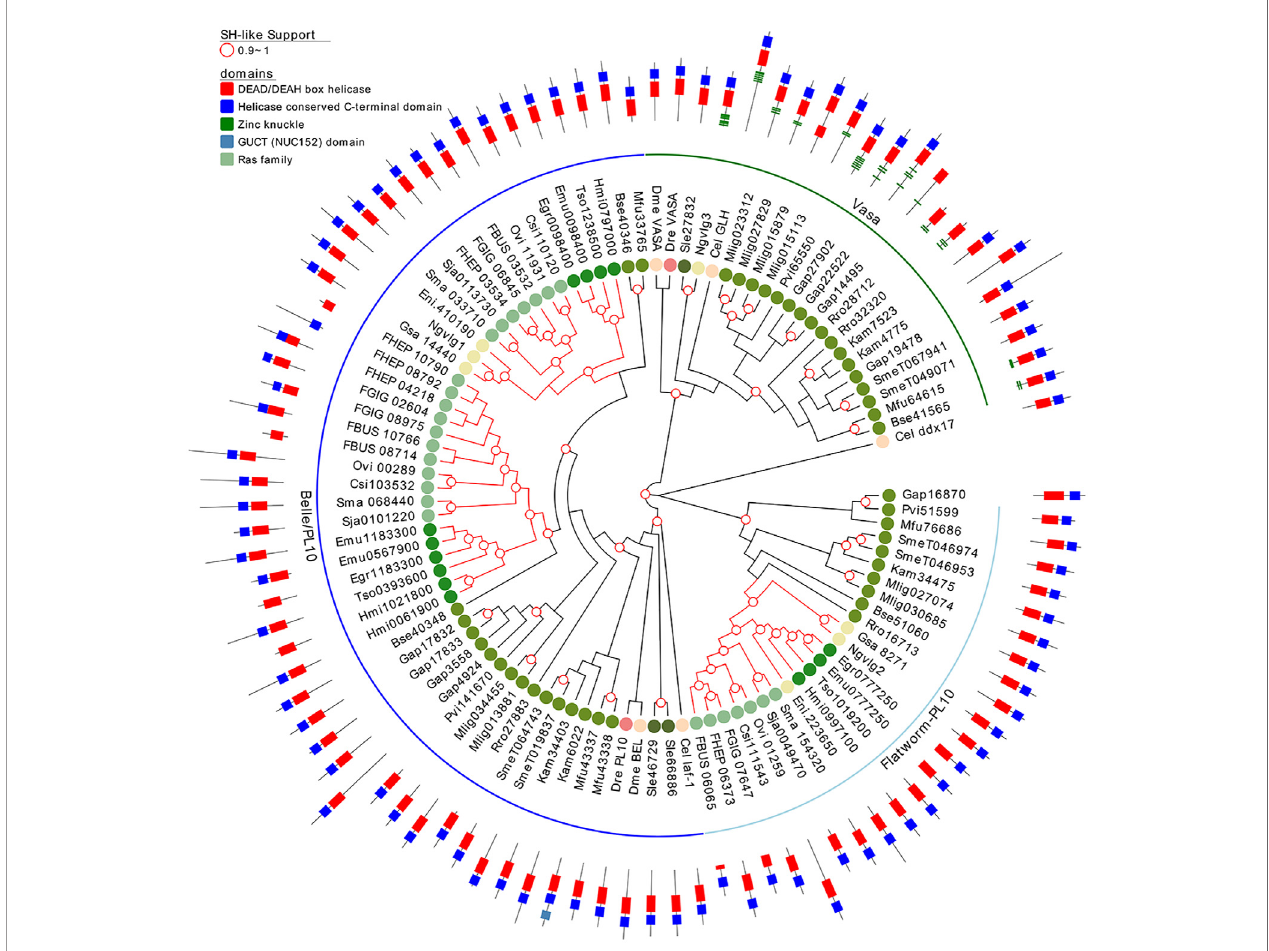
FIGURE 7 | A maximum likelihood tree of Vasa and Vasa-like proteins. SH-like approximate likelihood ratios are indicated. Conserved protein domains were predicted with HMMScan. Green and blue arches correspond to Vasa and Belle/PL10, respectively. Light blue arch corresponds to fl atworm PL10. Red branches correspond to Neodermatan species. Species abbreviations are indicated as in Figure 2